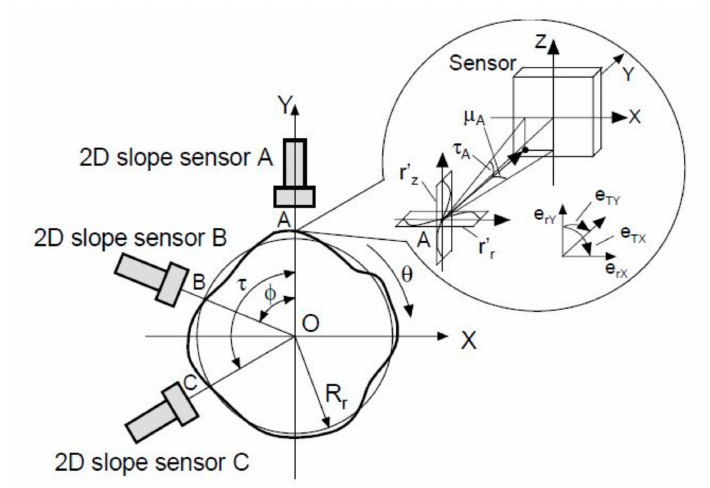
Figure 21. Principle of the three-point angular measurement method